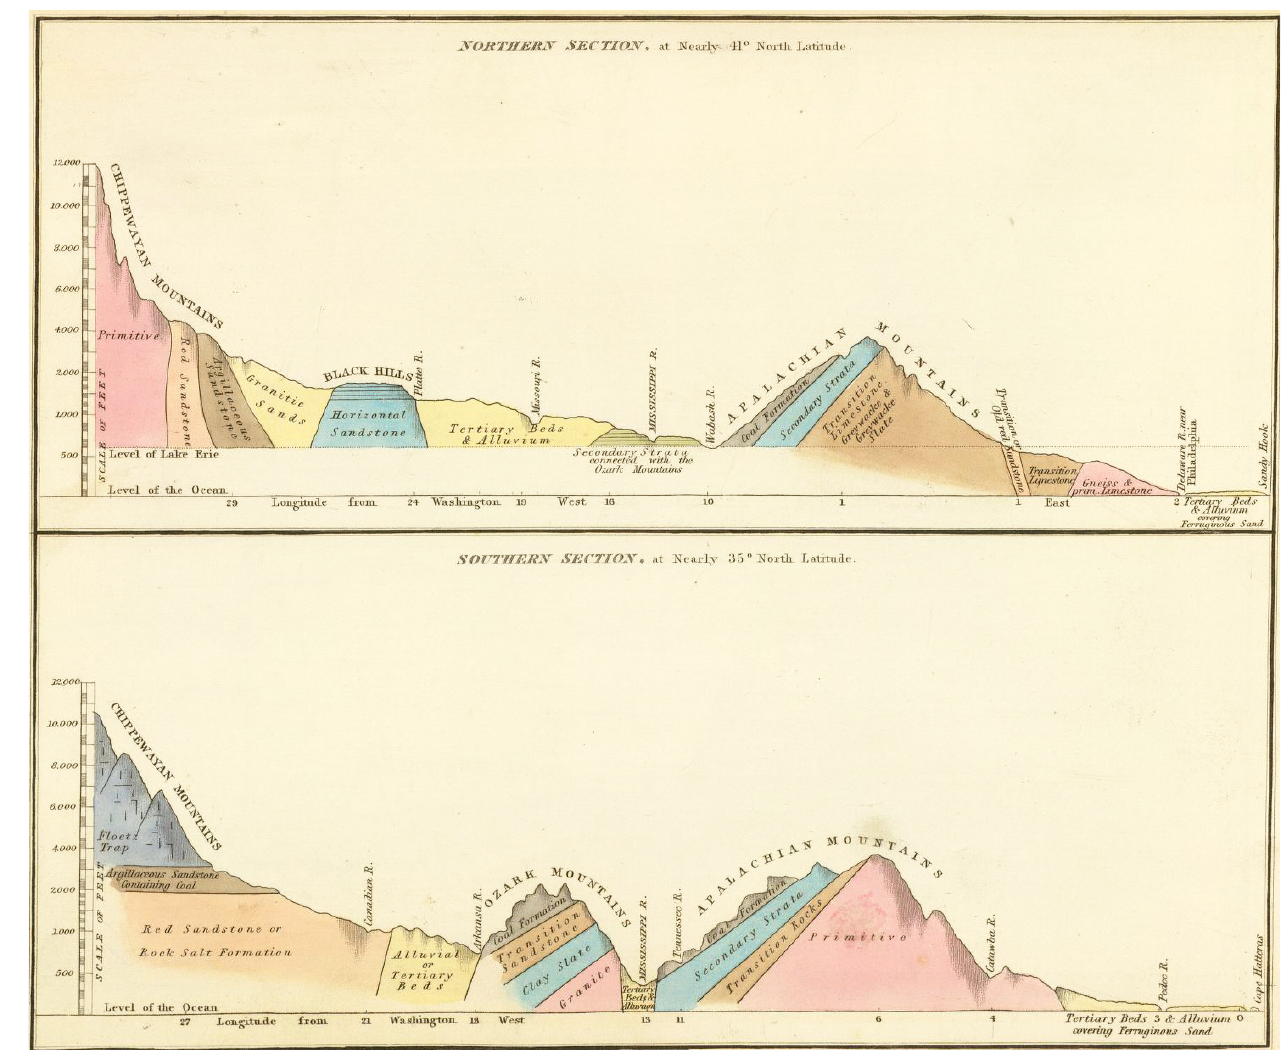
Figure 7. Hinton’s vertical sections based largely upon studies by James and Maclure (Hinton, 1832). The Ozark Mountains were mapped chiefly with “Transi- tion” and “Secondary” rocks plus coal, although subjacent “Primitive” rocks daylight on his vertical section (Fig.